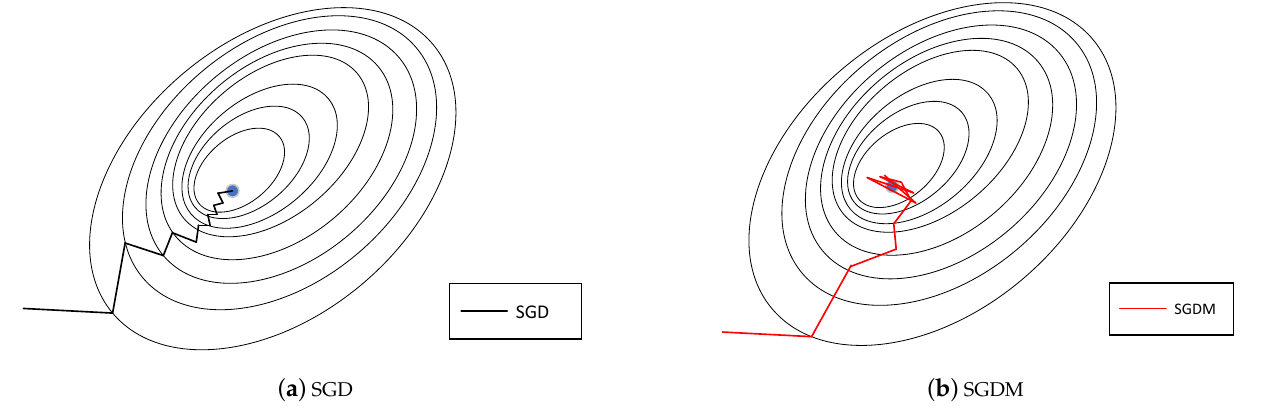
Figure 1. The performances of SGD and